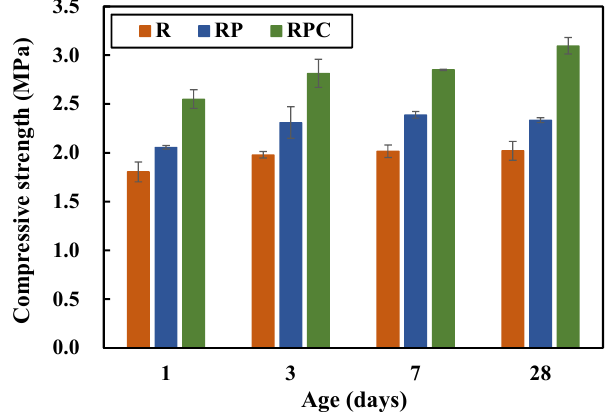
Figure 7. Compressive strengths of the four mixing combinations.